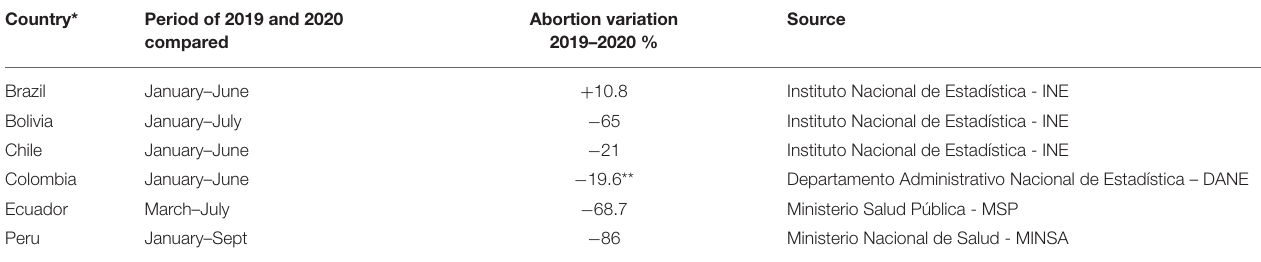
TABLE 9 | Variation in number of legal abortions performed during 2019–2020.